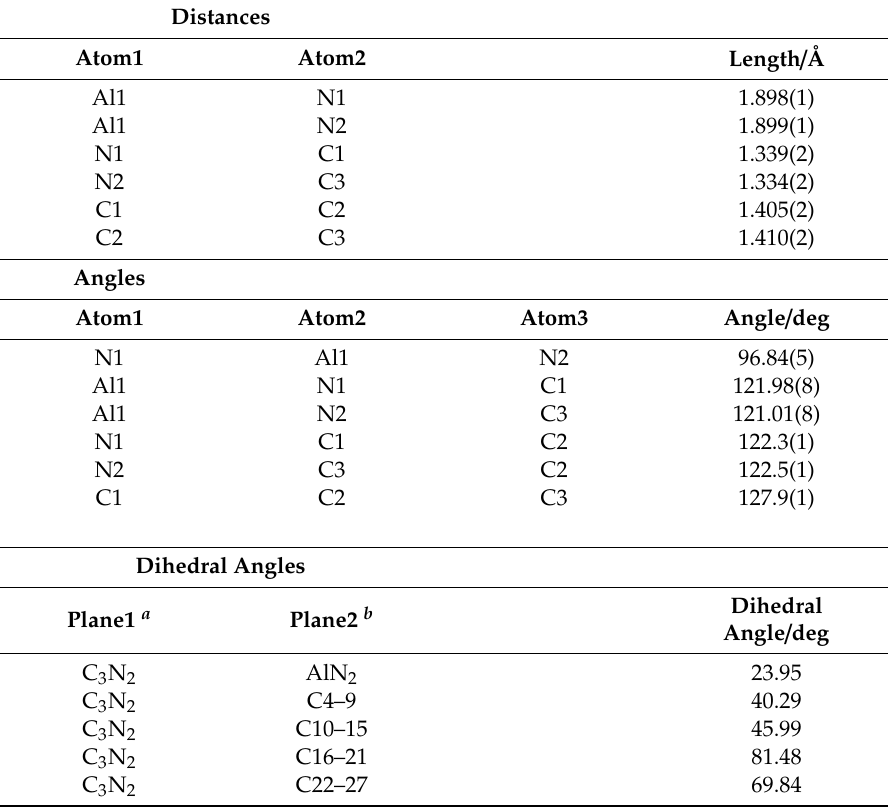
Table 1. Selected structural parameters of LAlH in the single